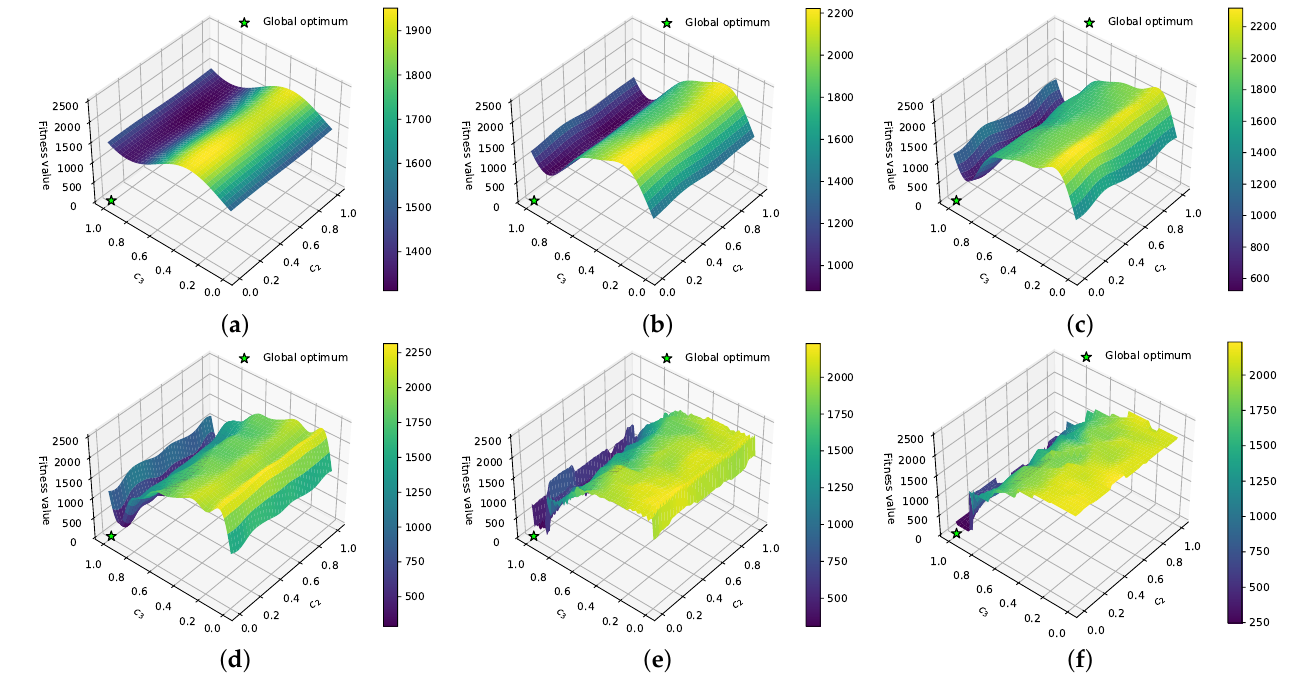
Figure 9. Surrogate models of the fitness landscape for the PE of the MM model dilated using the evolved DF, with γ = 2 ( a ), γ = 3 ( b ), γ = 5 ( c ), γ = 10 ( d ), γ = 50 ( e ), γ = 100 ( f ). The plots highlight that, even in the case of γ = 100, the global optimum cannot be properly reconstructed, as the excessively strong dilation caused by the evolved DF is detrimental to the optimization results when coupled to Fourier surrogate modeling.